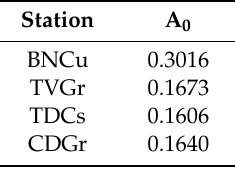
Table 2. Integral Albedo Coefficients at the zenith for all the sites.